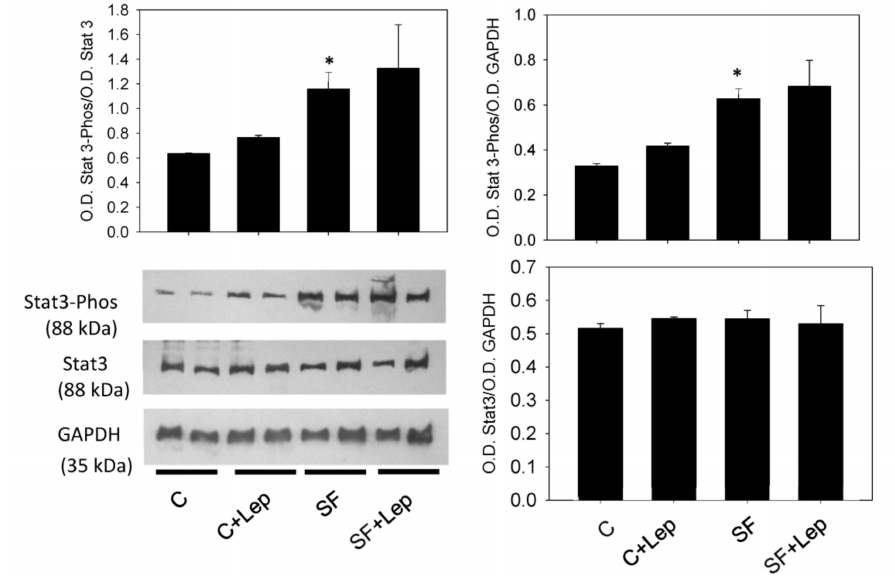
Figure 5. Effect of sucrose feeding and leptin treatment on STAT3 and STAT3 phosphorylation of aortic SMC. The proteins mentioned above were detected in aortic SMCs from C and SF rats and in cells treated with leptin at 40 ng/mL culture medium for 15 min stimulation. At the end of the experiment cell were lysed and proteins were quantified according to Bradford as described in Methods section. Eighty µ g protein of sample was loaded into an SDS-PAGE gel with 10% of the acrylamide. The graph corresponds to the ratio of the OD of STAT3 and STAT3-phosphorylated and the OD of GAPDH used as a control load. The values correspond to the mean +/ − SD (n = 4 different experimental animals). * p < 0.05 corresponds to C vs.